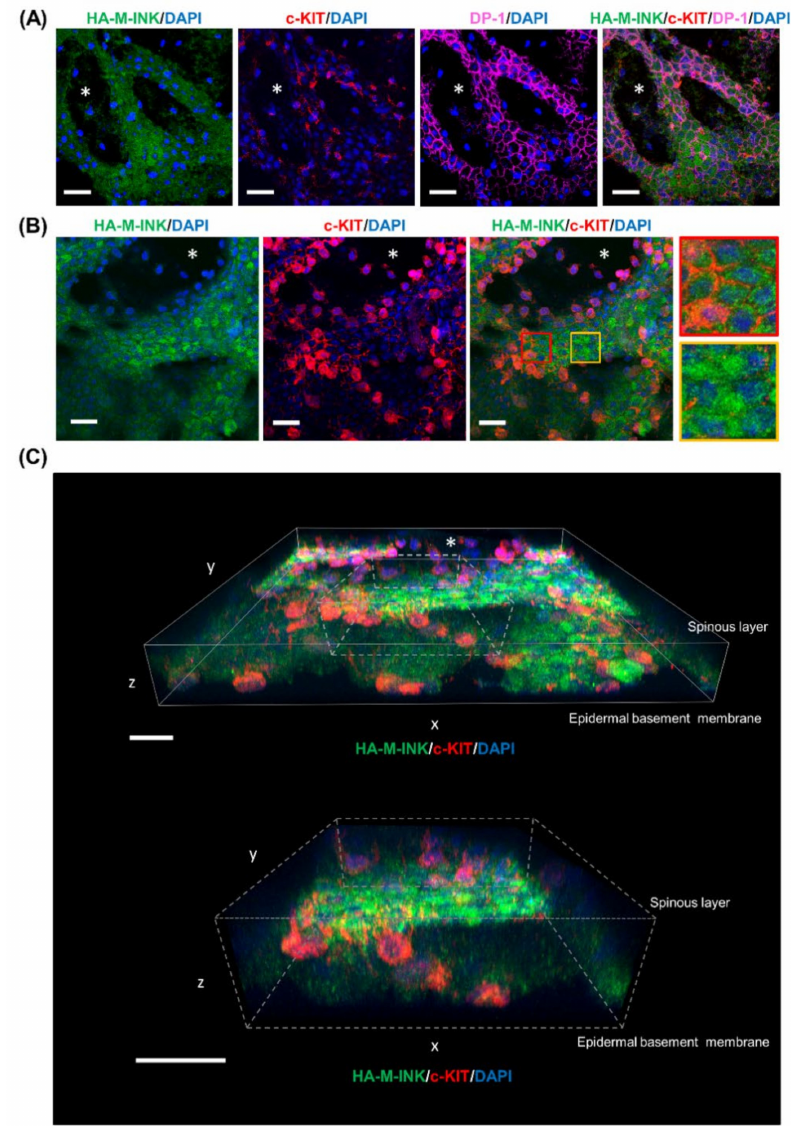
Figure 6. Immunostaining images and three-Dimensional (3D) fluorescence image of epidermal sheets. Epidermal sheets were prepared from a skin sample (phototype V) and stained for HA-M-INK and other markers. Confocal microscopy images were taken from the dermal side and obtained from the epidermal basement membrane to the spinous layer. The asterisks indicate the epidermal structures protruding into the papillary dermis. ( A ) The samples were stained for HA-M-INK (green), c-KIT (red), DP-1 (magenta), and DAPI (blue) and observed in basal layer keratinocytes. ( B ) The samples were stained for HA-M-INK (green), c-KIT (red), and DAPI (blue) and observed from the basal layer side to the spinous layer at 0.5- µ m intervals; the images were then superimposed. The insets are magnified views of the boxed areas to show the distribution of melanin in keratinocytes in contact with neighboring (red inset) or non-neighboring (yellow inset) melanocytes. ( C ) The image was constructed three-dimensionally from the images in ( B ). The bottom image is a magnified view of the dotted line areas. Scale bars = 20 µ